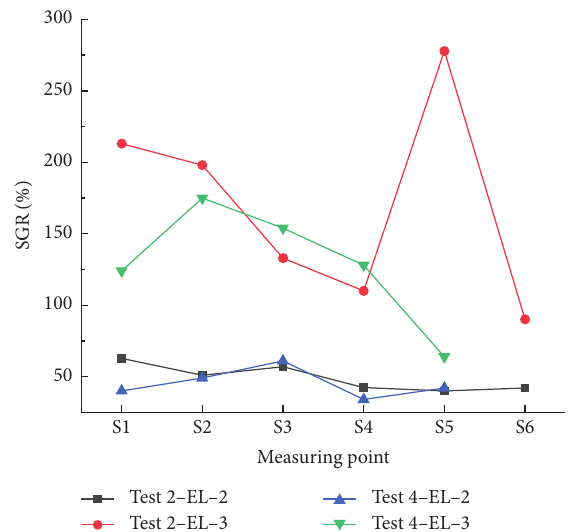
Figure 15: Case 3 strain growth rate of structure.